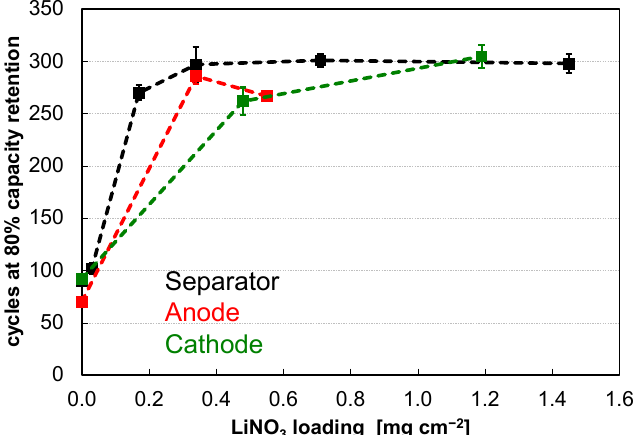
Figure 6. Cycle life (at 80% capacity retention) of full cells with CLM00001 anodes (standard PSD) and DEC/EC-based electrolyte as a function of the LiNO 3 loading applied on the anode, cathode or separator (4.2–3.0 V range). The increasing nitrate content improves stability from about 100 cycles to 300 cycles. Cycle numbers represent mean values in a series of three cells, error bars indicate the standard deviation.